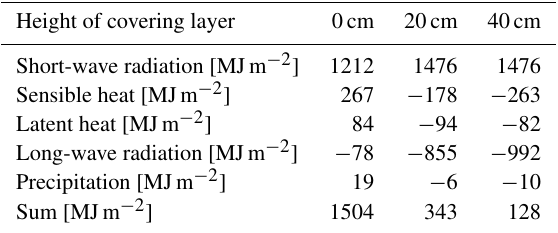
Table 5. Net energy fluxes at the surface of the Flüela snow heap summed for the entire simulation period without and with a 20 and 40cm sawdust